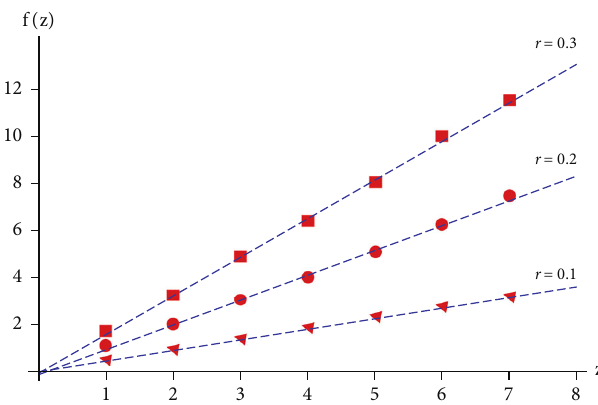
Figure 3: Numerical results for the entanglement entropy for the UV state obtained using the random circuit (at t = 8 ) with parameters N = 22, p = 0 : 9, r = 0 : 2 . Entanglement entropy of a subsystem S ð x Þ can be approximated by a logarithmic function of its size x as required by the